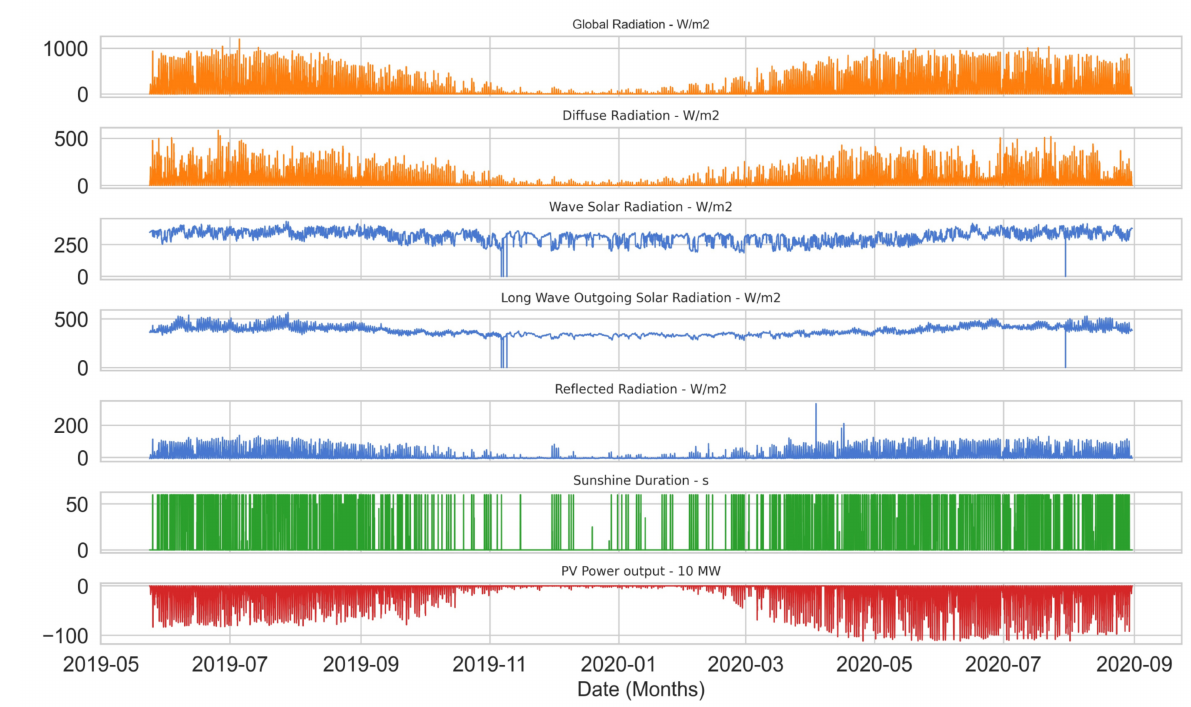
Figure 6. FMI radiation observation